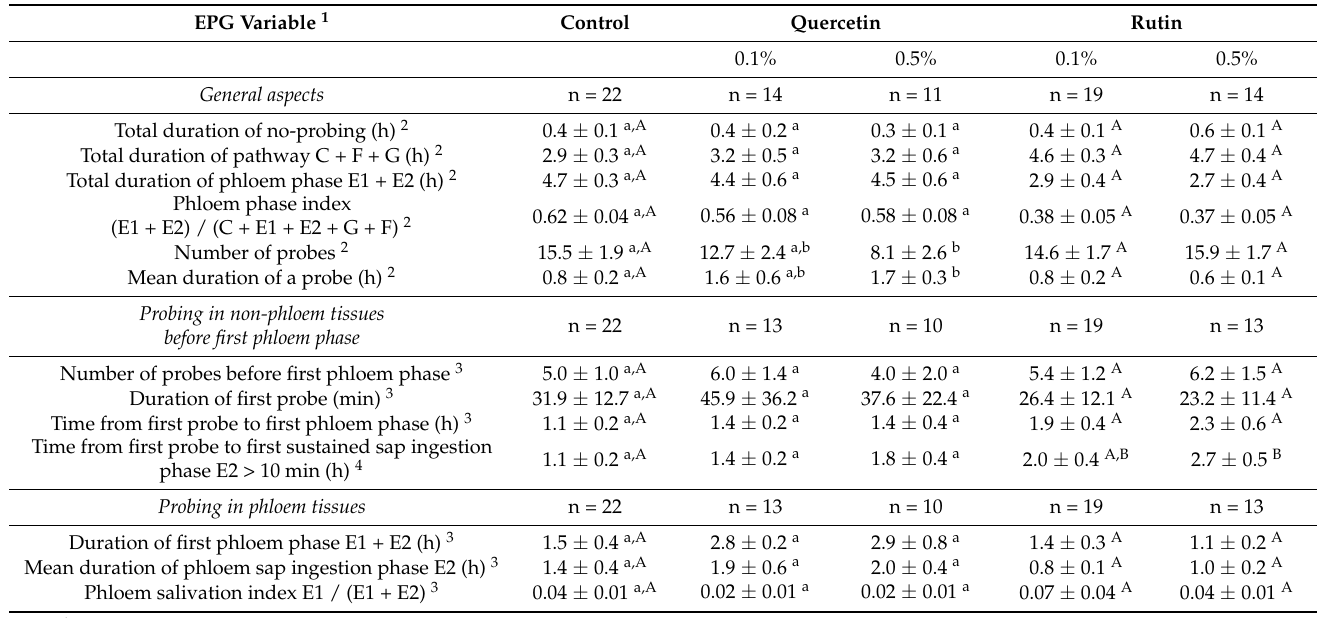
Table 1. EPG-recorded stylet penetration activities of Acyrthosiphon pisum on Pisum sativum treated with 0.1% and 0.5% ethanolic solutions of quercetin and